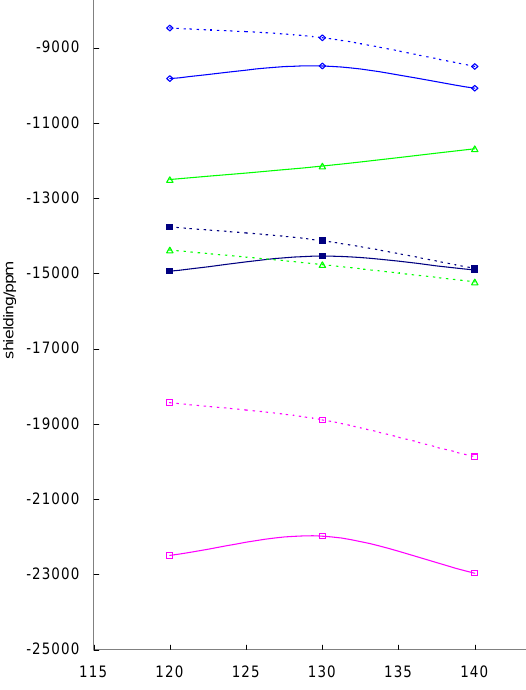
Figure 4. Variation of calculated 59 Co shielding with CoNO angle for model nitrosyl complexes: dithiocarbamato complex with optimised CoNO geometry (solid line), model Schiff base complex with r(CoN) = 1.738Å and r(NO) = 1.12Å (dotted line) ■ isotropic shielding, □ σ